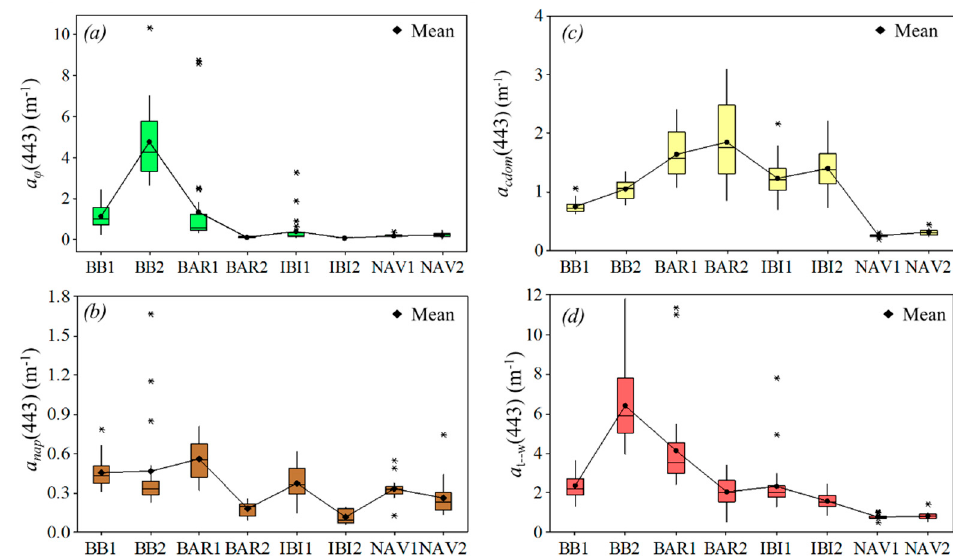
Figure 7. Boxplot of absorption coefficients at 443 nm obtained in all of the field campaigns: (a) a φ (443)(m -1 ); (b) a nap (443)(m -1 ); (c) a cdom (443)(m -1 ); and (d) a t-w (443)(m -1 ).